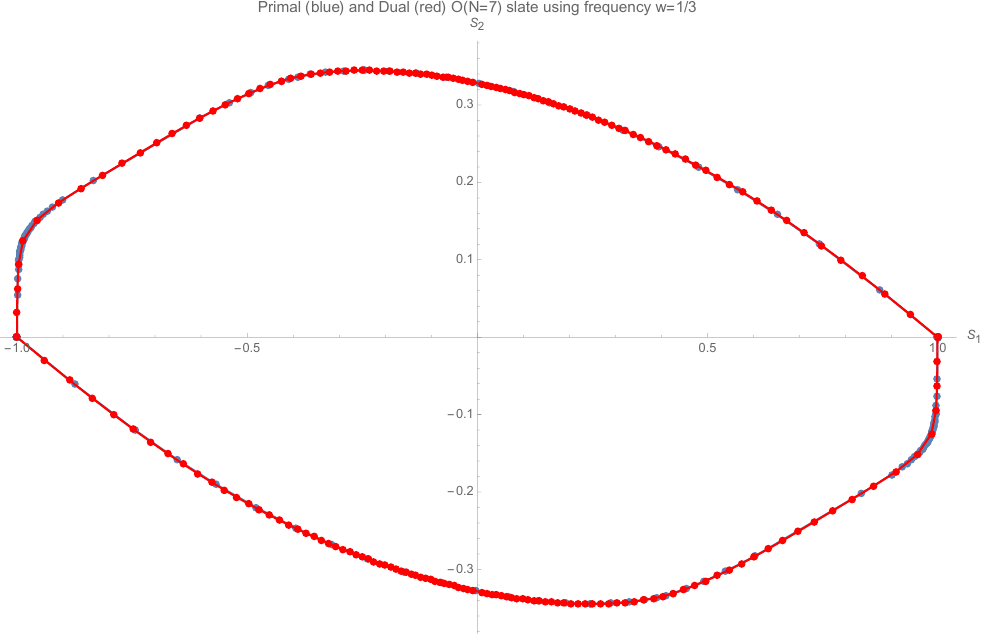
Figure 12 . Primal (blue) and Dual (red) estimates of the slate boundary with the parameters described in the text. The optimal bound must be somewhere between the two curves; since they are basically on top of each other already, we conclude that the dual and primal problems for this large period are a very good approximation of the optimal bound. (The blue points are more densely located in larger curvature regions since we used the normal functionals while the red dots are more uniformly distributed since we found them using the radial